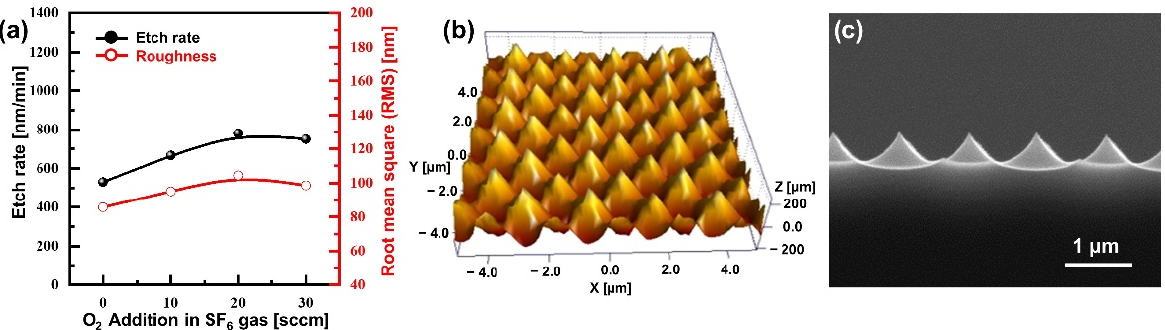
Figure 3. ( a ) Etch rate and surface roughness following the amount of O 2 gas added to 100 sccm of SF 6 gas. ( b ) AFM and ( c ) cross-sectional SEM images of silicon substrate etched in SF 6 /O 2 plasma with 20 sccm O 2 gas addition.